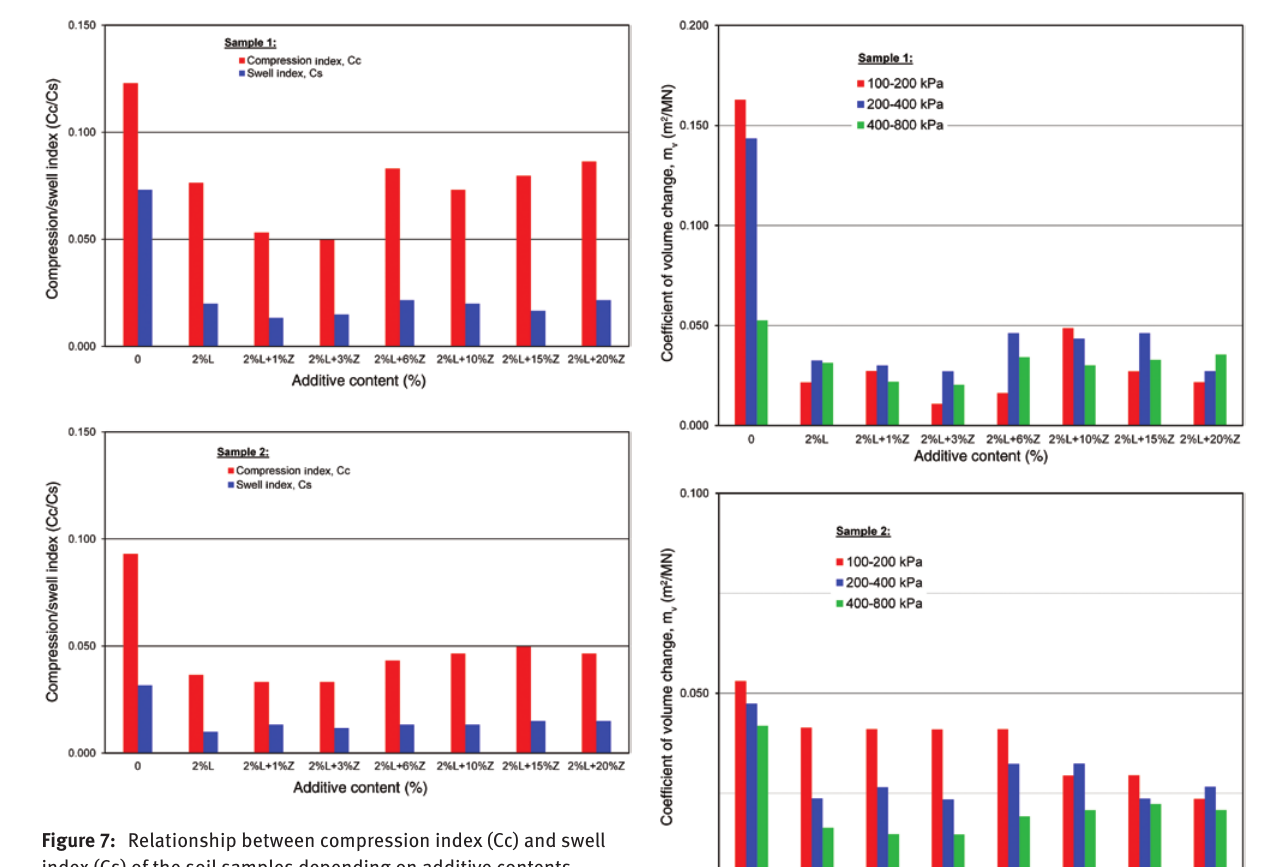
Figure 8: Variations of coefficient of volume change (m ent additive content.